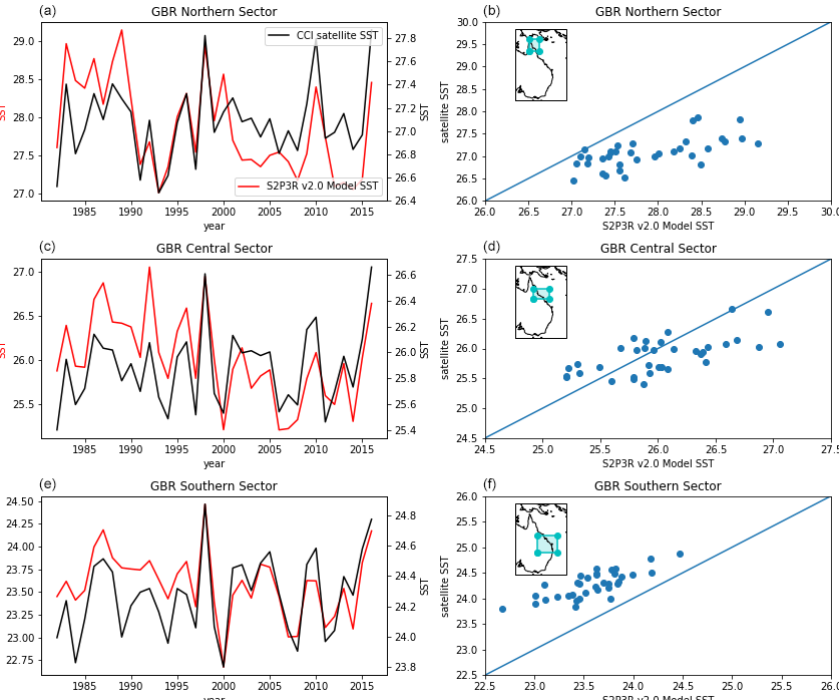
Figure 16. Comparison of interannual SST variability between S2P3R v2.0 and satellite (Merchant et al., 2019) over the GBR, subdivided into three latitudinally delineated regions. These regions are identified in the inset